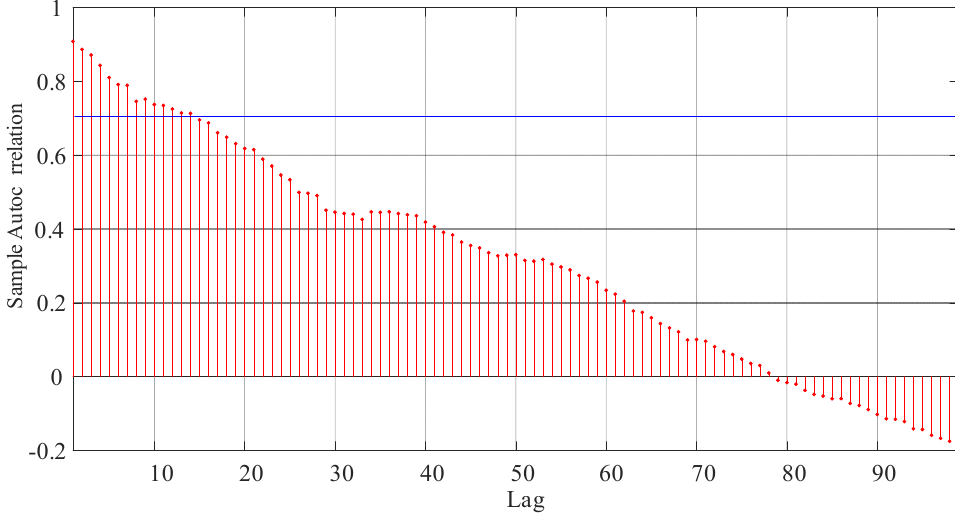
Figure 12. Division of training set and prediction test set of CDI.